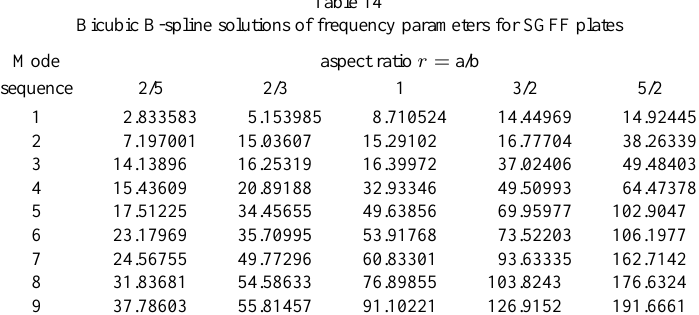
Table 14 Bicubic B-spline solutions of frequency parameters for SGFF